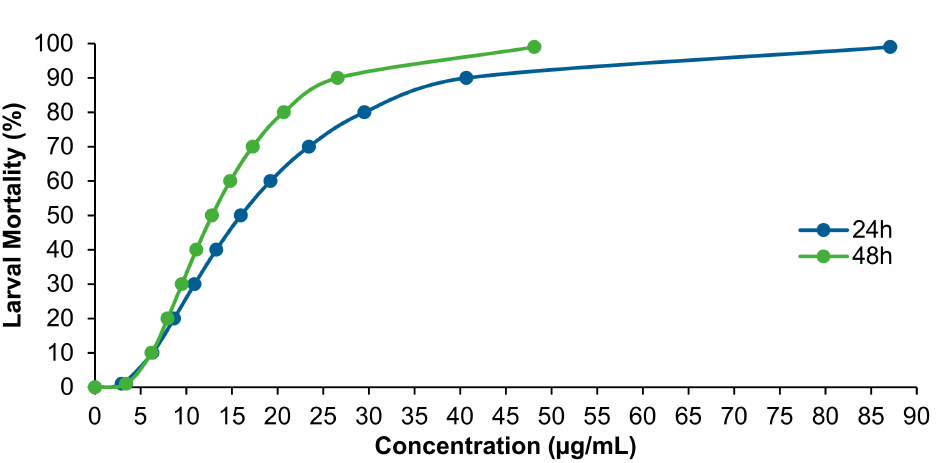
Figure 2. Probit analysis of the larvicidal activity of the hexane extract of O. basilicum leaves against third instar Ae. albopictus larvae after 24 and 48 h exposure